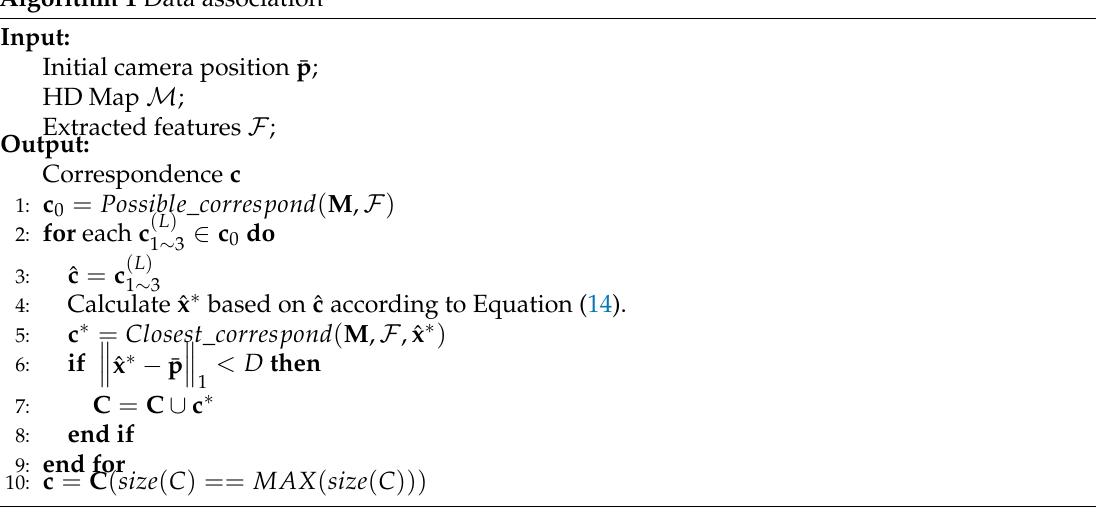
Algorithm 1 Data association